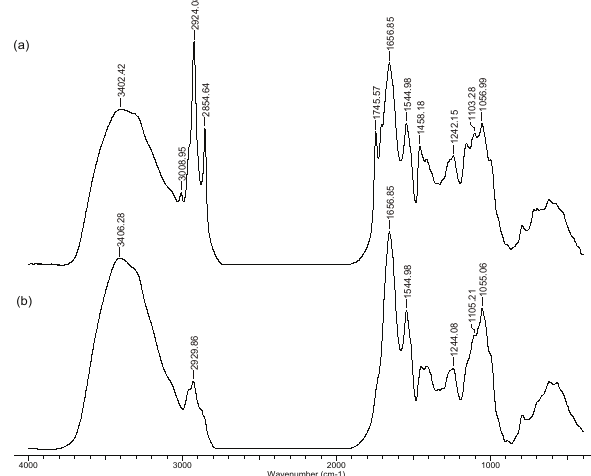
Figure 1 : FT-IR spectra of mustard biomass before (a) and after oil extraction (b).